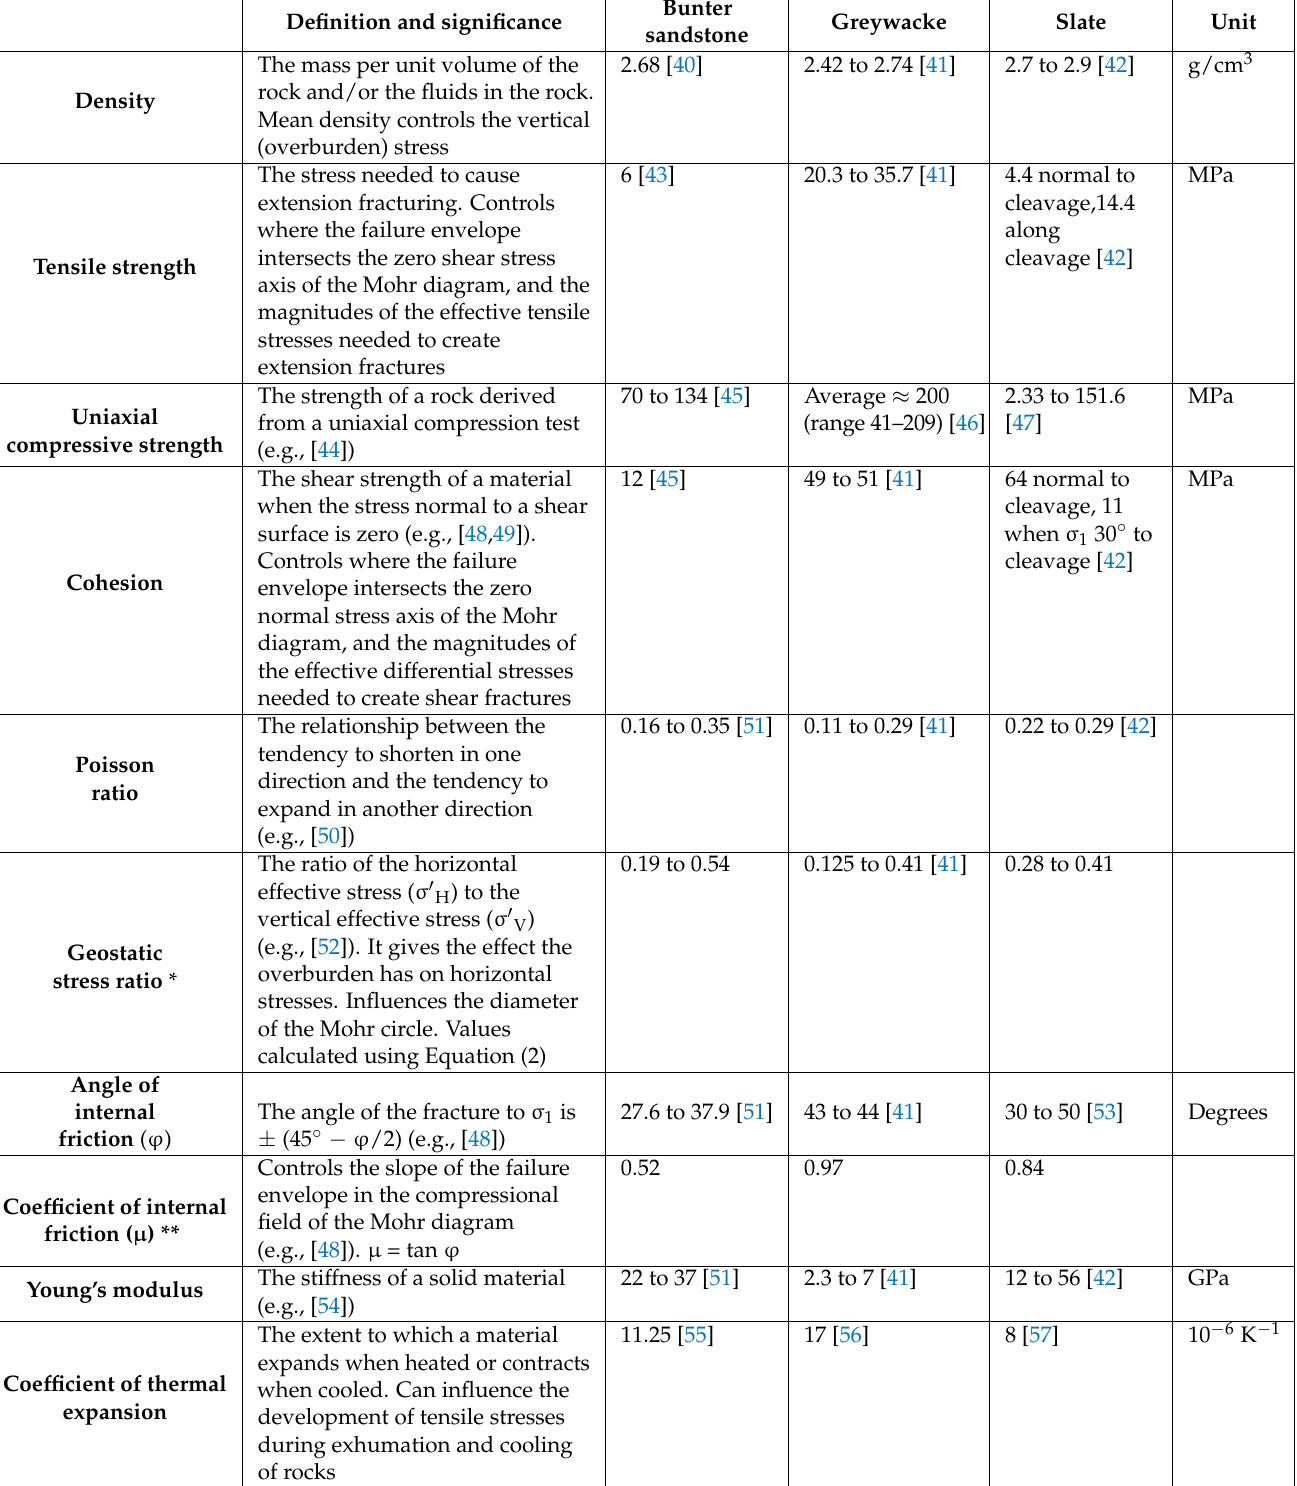
Table 2. Parameters used in the modelling. * Geostatic stress ratios are calculated from the Poisson ratios. ** Representative values of the coefficient of internal friction are used here, using the approximate median value of the range of internal angles of